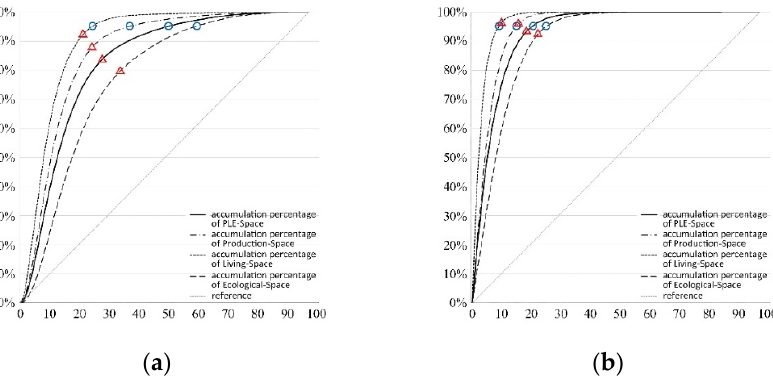
Figure 7. PLES cumulative curves of facilities. ( a ) Distance to interchanges; ( b ) distance to roads.